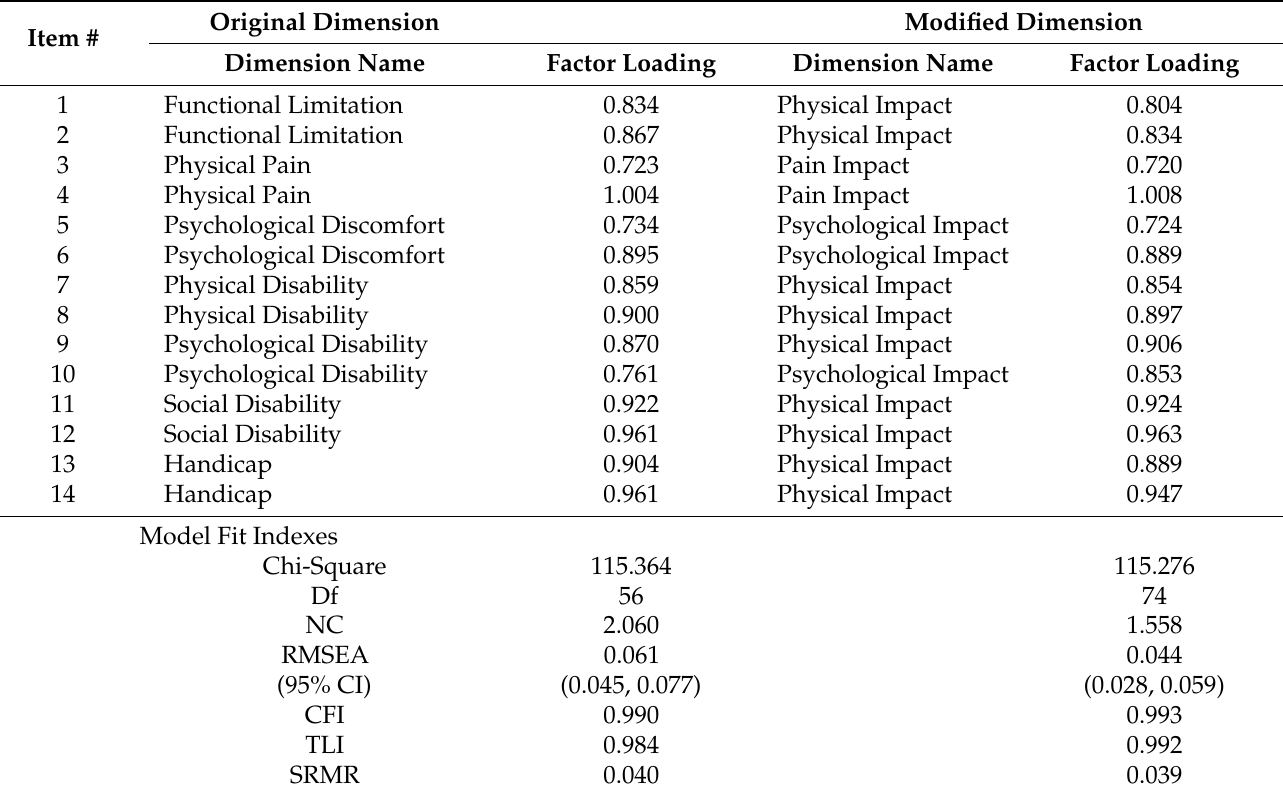
Table 4. Factor structures of the OHIP-14 in pregnant women: original vs.